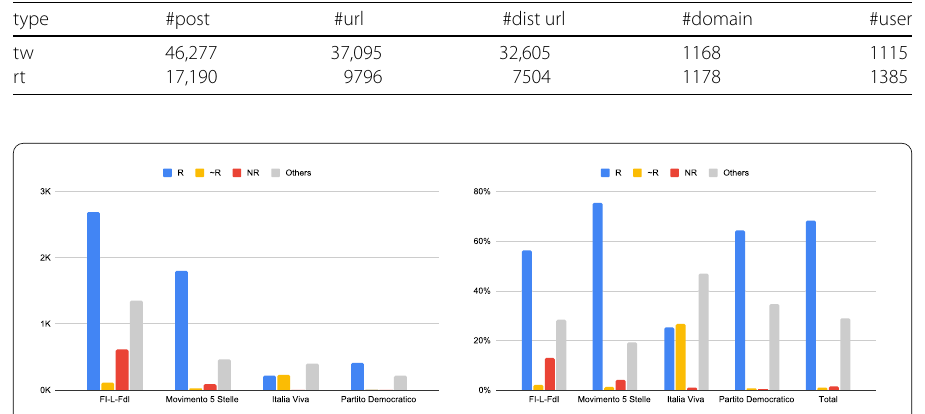
Figure 2 Number (left panel) and percentage (right panel) of Reputable, Circa Reputable, and Non Reputable news sites shared by the political subcommunities – Validated network of verified